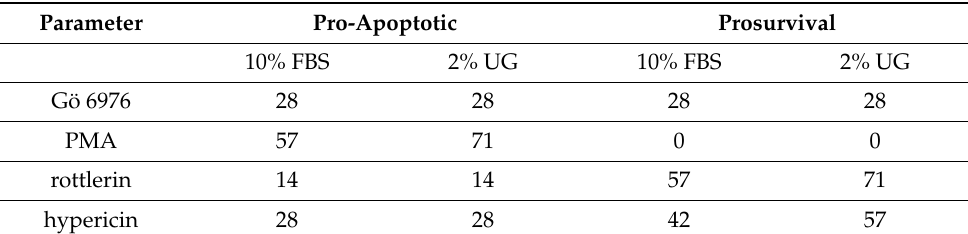
Table 3. Probability of pro-apoptotic and prosurvival stimuli in U87 MG cells after Gö 6976, PMA, rottlerin, and hypericin application. The probabilities were derived from the categorical parameters based on relative abundances presented in Figure 1.